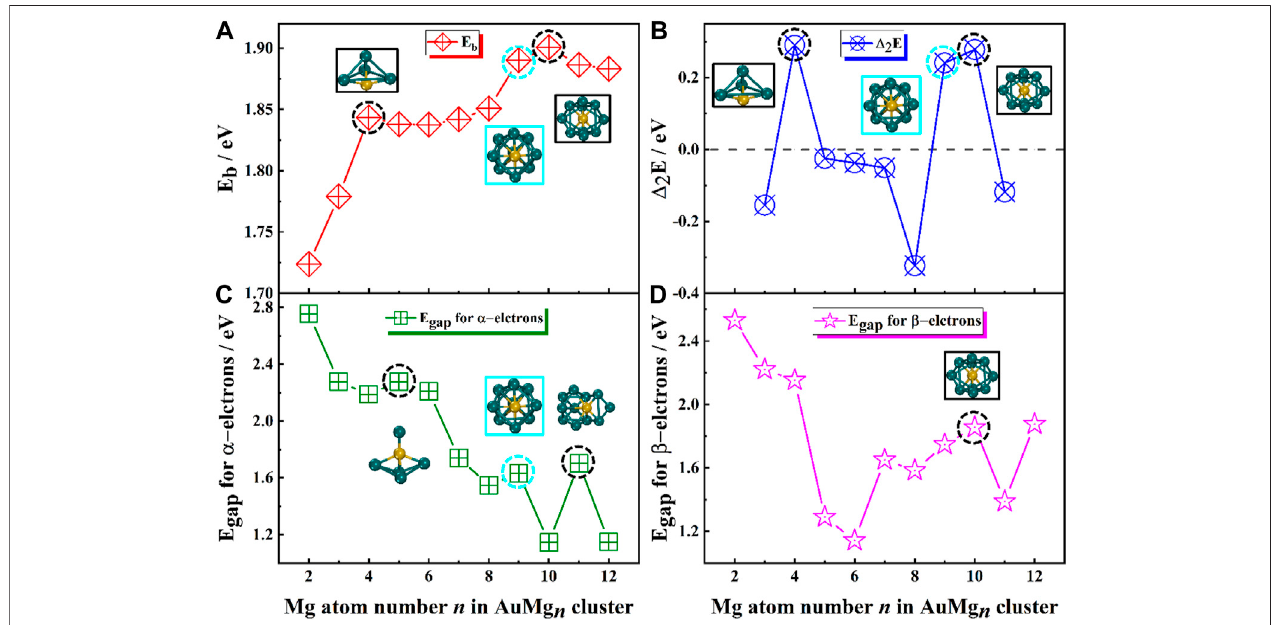
FIGURE 3 | (A) Average binding energy E b , (B) The second order difference energy Δ 2 E, (C) The HOMO-LUMO energy gap E gap for α -electrons, (D) The HOMO- LUMO energy gap E gap for β -electrons in the ground state of AuMg n ( n = 2 – 12)